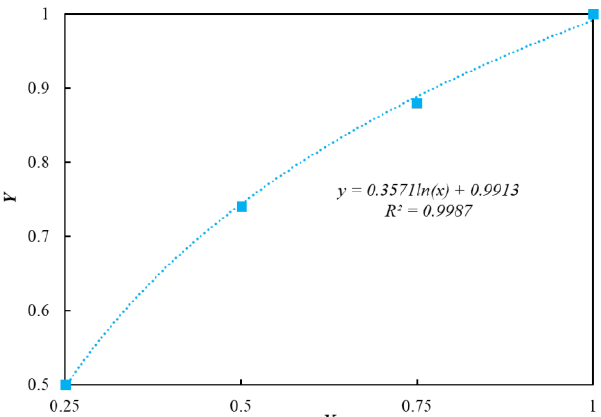
Figure 9. The influence of total charge quantity on downhole perforation peak pressure.